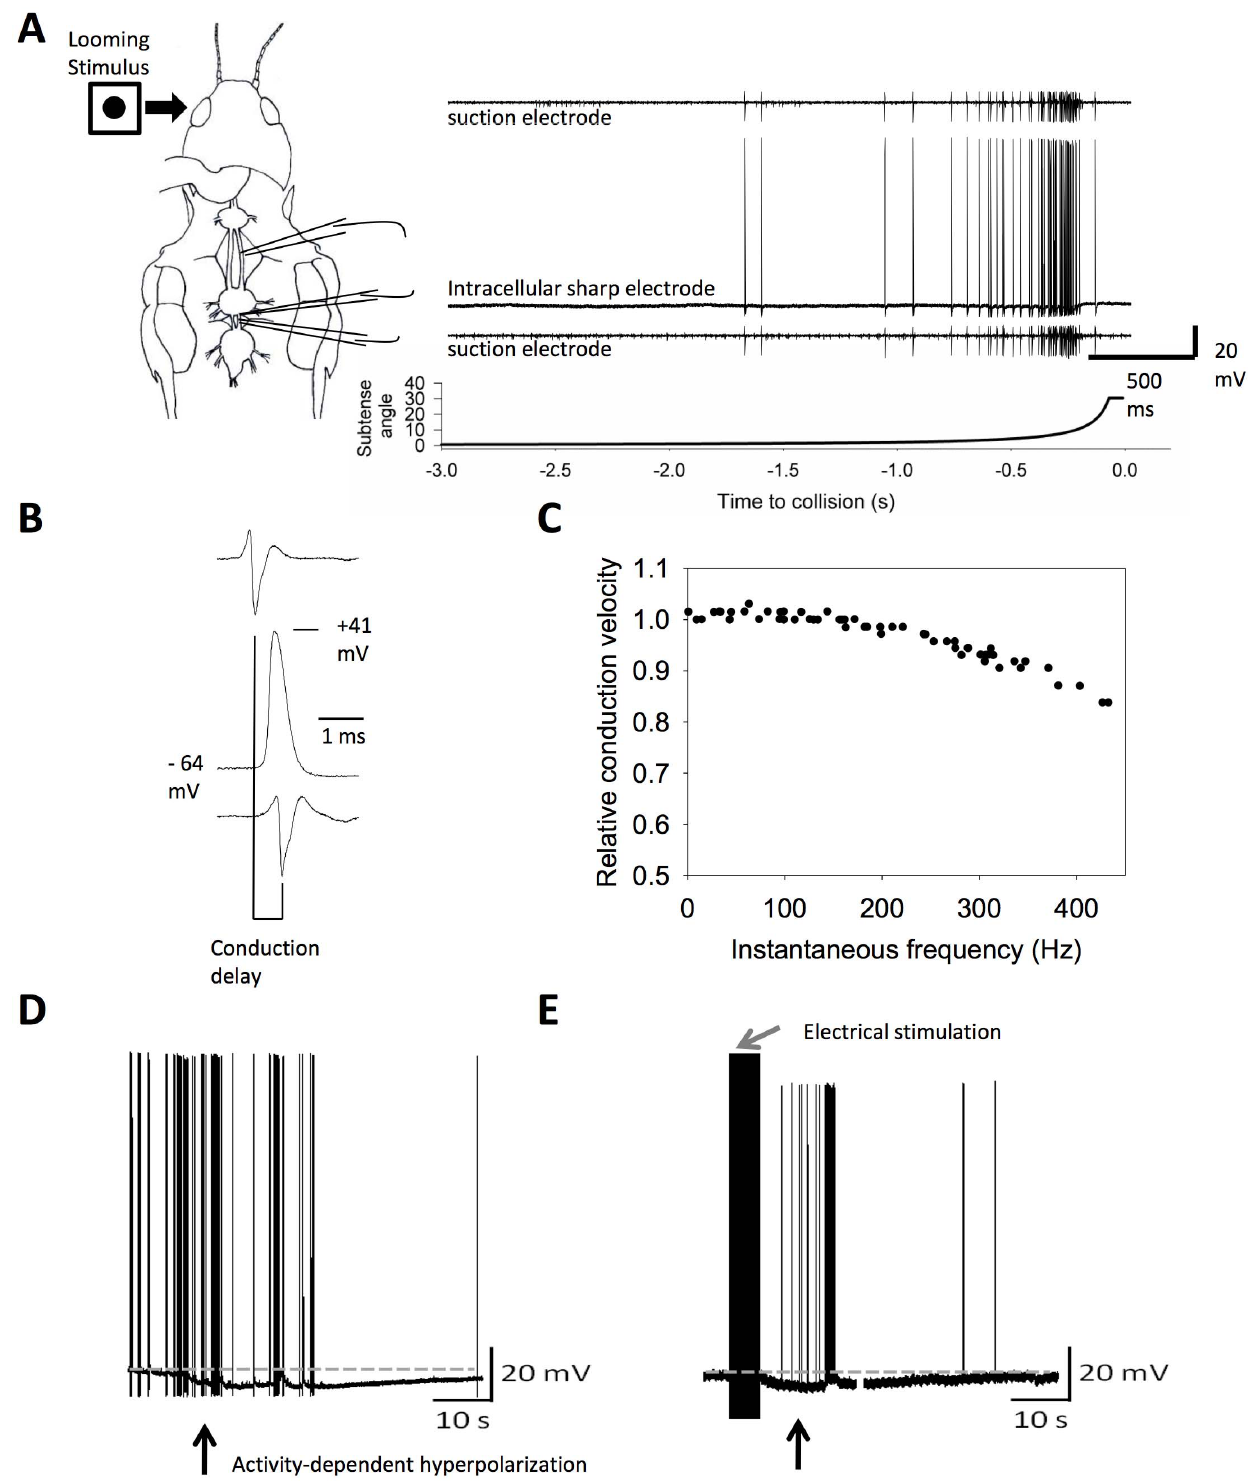
Figure 1. Neural performance can be monitored using the visual looming detector circuit, via the descending contralateral movement detector (DCMD). (A). The timing and electrophysiological properties of APs elicited by a 1 m/s looming stimulus can be recorded from the axon of DCMD. (B). Conduction delay of APs recorded between two extracellular suction electrodes can be used to calculate relative conduction velocity. (C). Quantification of differences in conduction velocity with increasing instantaneous frequency. (D). Activity-dependent hyperpolarization of DCMD (arrow) can be monitored in response to visual stimuli. (E). Electrical stimulation of the axon to evoke 1000 APs (grey arrow) is also sufficient to induce an activity-dependent hyperpolarization (black arrow).